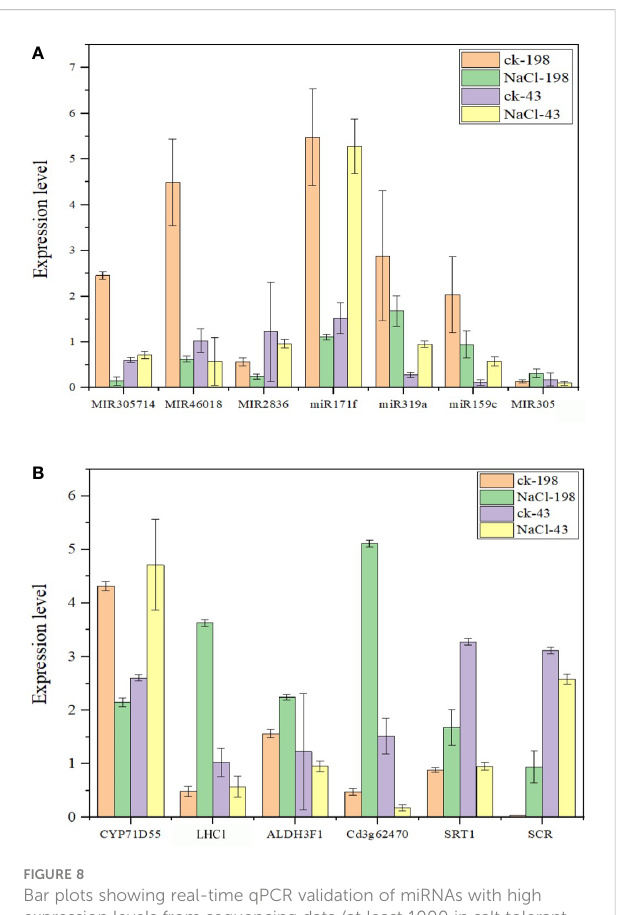
FIGURE 8 Bar plots showing real-time qPCR validation of miRNAs with high expression levels from sequencing data (at least 1000 in salt tolerant vs sensitive regime) (A) and respective target genes for the selected miRNAs (B) . The data are the means of four replicates. Fold change below 1 is downregulation and above 1 is upregulation.